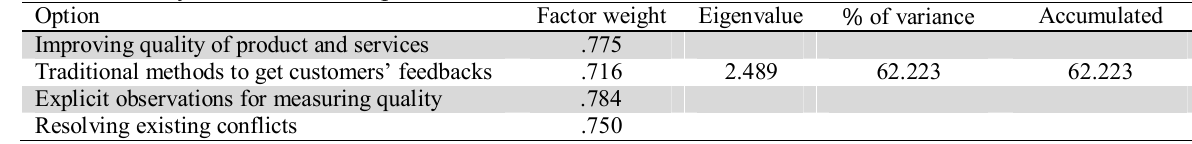
The summary of different components associated with measurement attributes Option Factor weight Eigenvalue % of